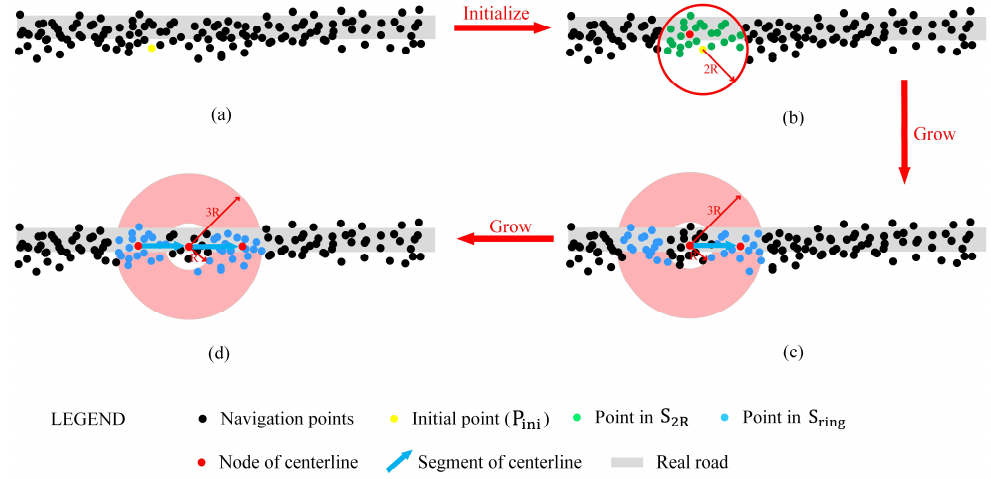
Figure 2. The main steps of RSC (ring-stepping clustering) are as follows: ( a ) a random GNSS (global navigation satellite system) point is chosen as the initial point, ( b ) the initial node is selected from the point set S 2R of the initial point, and ( c , d ) the next node is selected from the point set S ring of the current node.